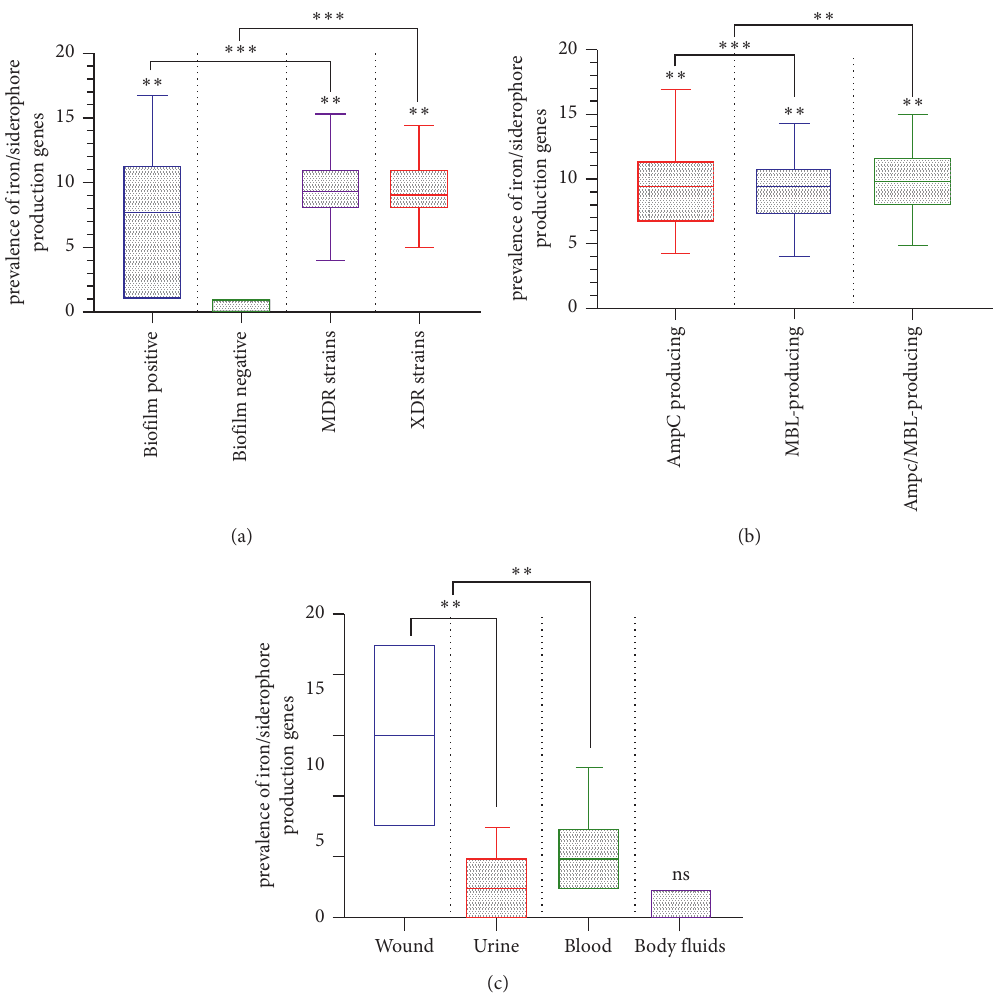
Figure 3: Correlation between the iron/siderophore mediate gene, biofilm formation, separated clinical isolates, and antibiotic resistance in A. baumannii . (a) Correlation between antibiotic resistance, biofilm formation, and iron/siderophore mediate gene. (b) Correlation between β -lactamase enzymes and iron/siderophore mediate gene. (c) Correlation between clinical sample type and iron/siderophore mediate gene. Each data set was analyzed using the Student’s t -test, Tokay, and the two-way ANOVA and was presented as mean+SEM. ∗ p value < 0.05; ∗∗ p value < 0.01; ∗∗∗ p value < 0.001; ∗∗∗∗ p value < 0.0001. ns: